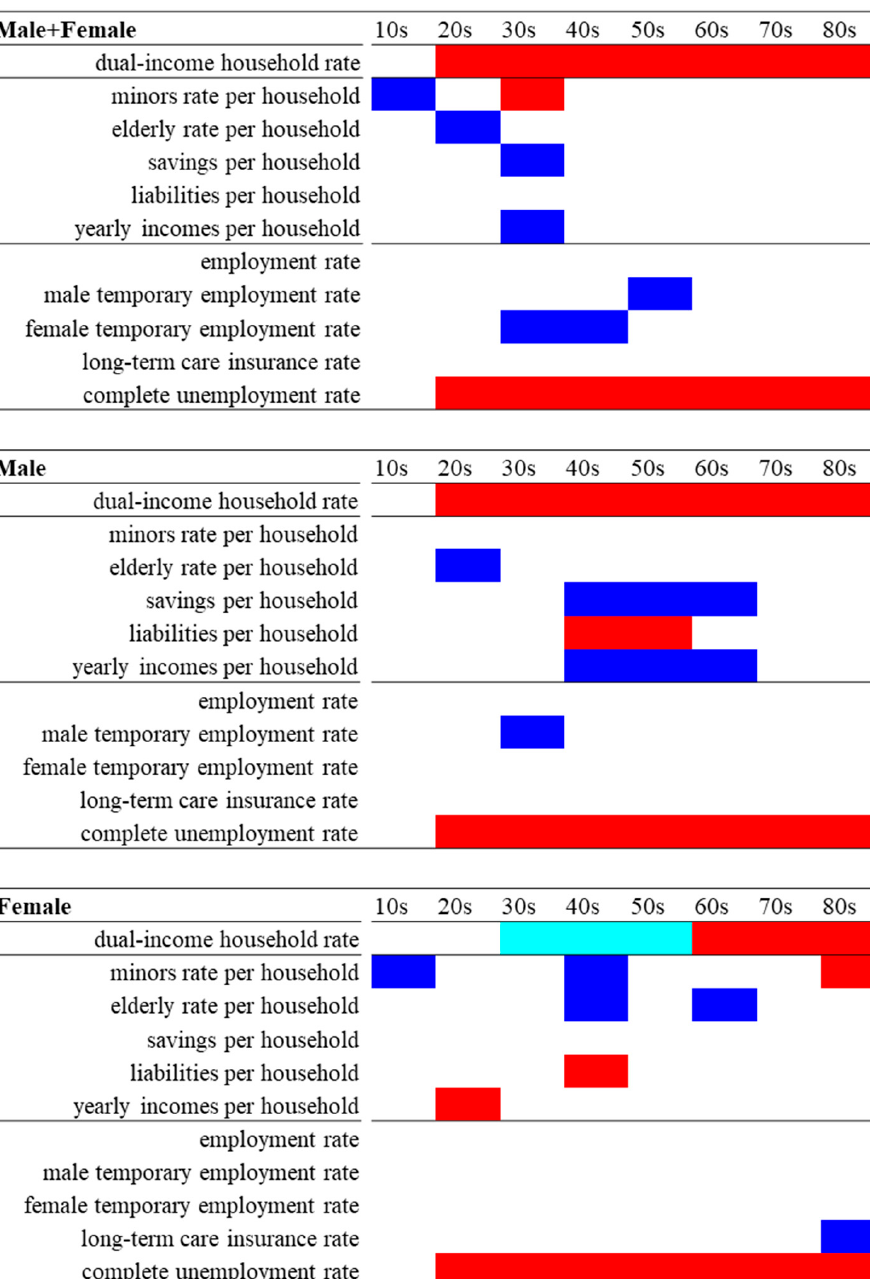
Figure 2. Summary of impacts of dual-income household rate, household structural and social/employment factors on suicide mortalities of Male + Female, Male and Female disaggregated by ages between 2009 and 2017. Blue and red columns indicate significant factors for decreasing and increasing suicide mortalities caused by each motive, respectively, in Model_2. Light blue column indicates significant factors for decreasing suicide mortalities caused by each motive in Model_1, but not in Model_2.